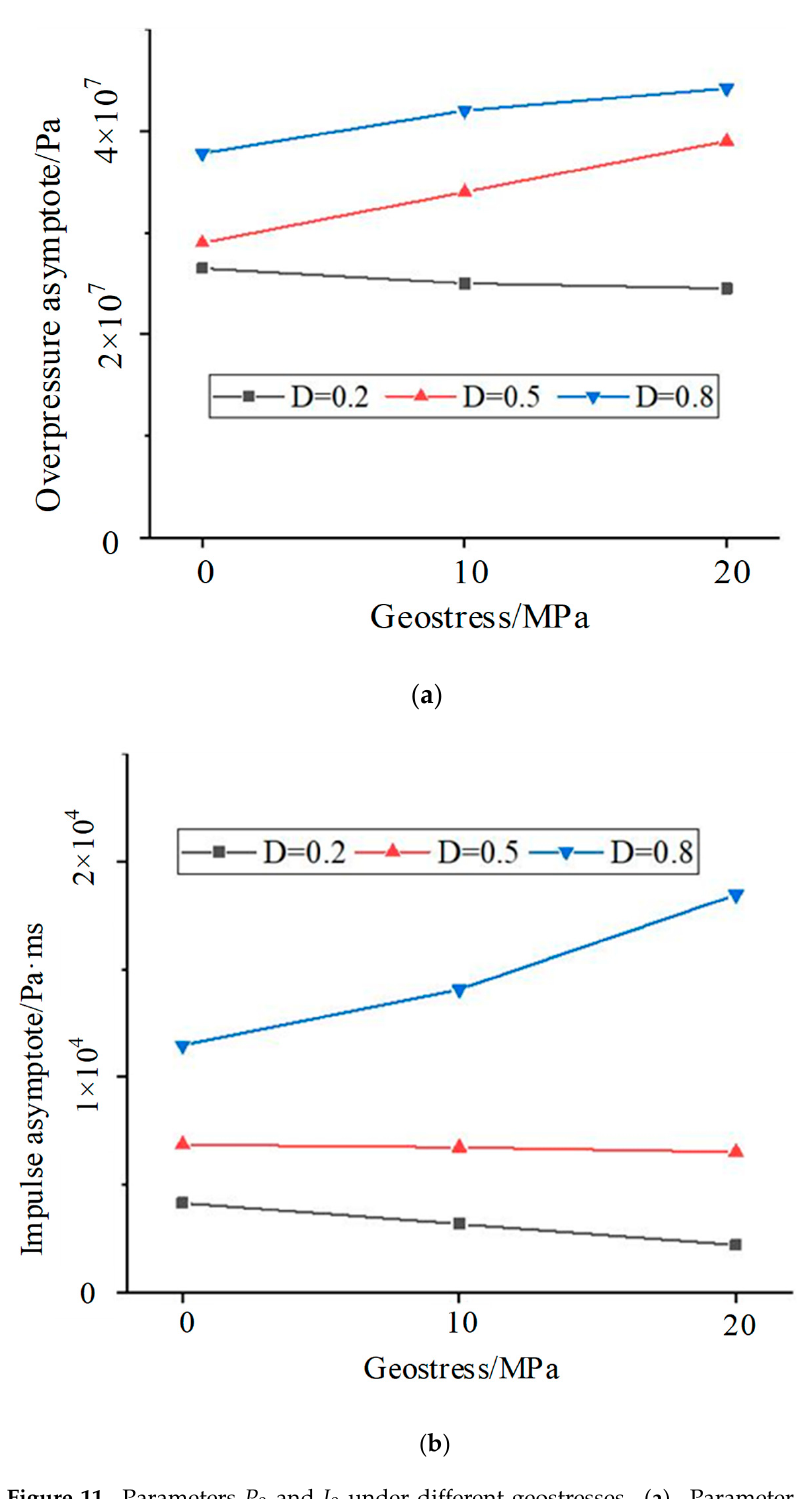
Figure 11. Parameters P 0 and I 0 under different geostresses. ( a ). Parameter P 0 under different geostresses and ( b ). Parameter I 0 under different